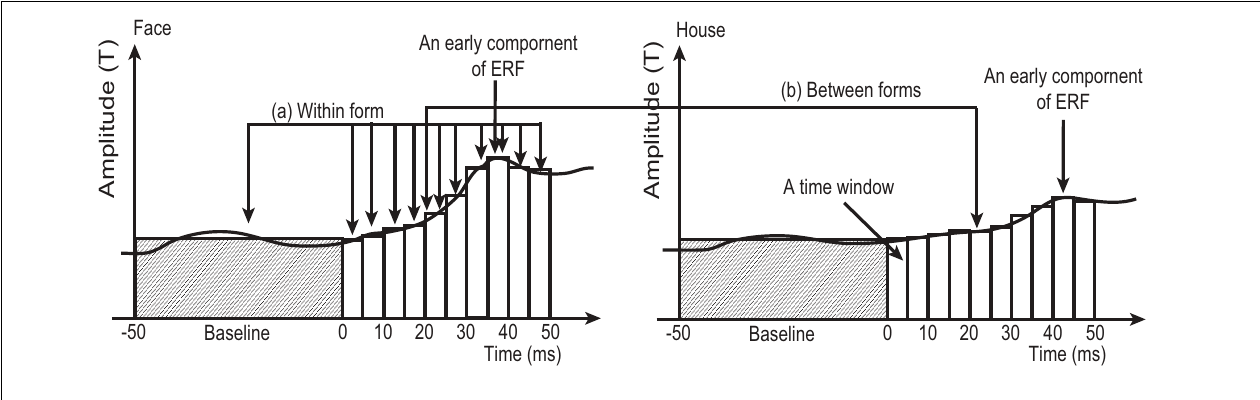
FIGURE 3 | Schematic figure, not using real data, to illustrate the two types of comparison in the sensor-level analysis employed in this study. (A) Within form comparison: Average RMS amplitudes at each time window (5ms in width) between 0 and 50ms after stimulus onset were compared against the average amplitude during baseline ( − 50 to 0ms), using One-Way ANOVA for repeated measures followed